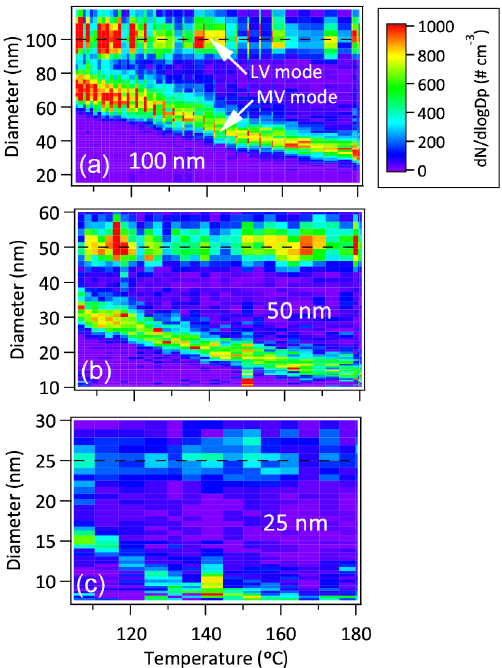
Figure 3. Campaign-average V-TDMA volatility spectra of (a) 100nm, (b) 50nm, and (c) 25nm particles measured 10m from the highway in summer. Figure S9 shows similar plots for the winter data